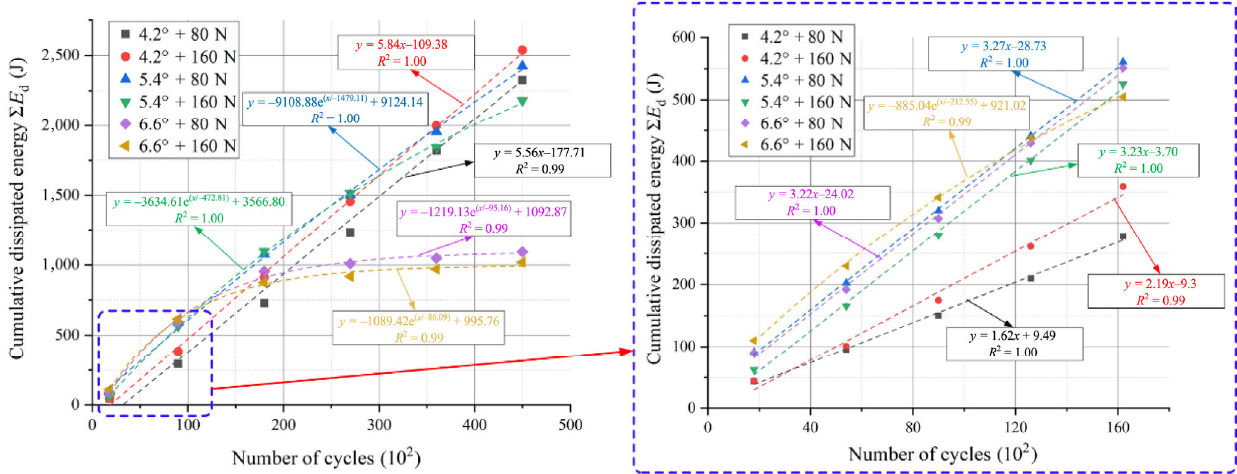
Fig. 16 Cumulative dissipated energy of different twist angles and lateral loads under dry